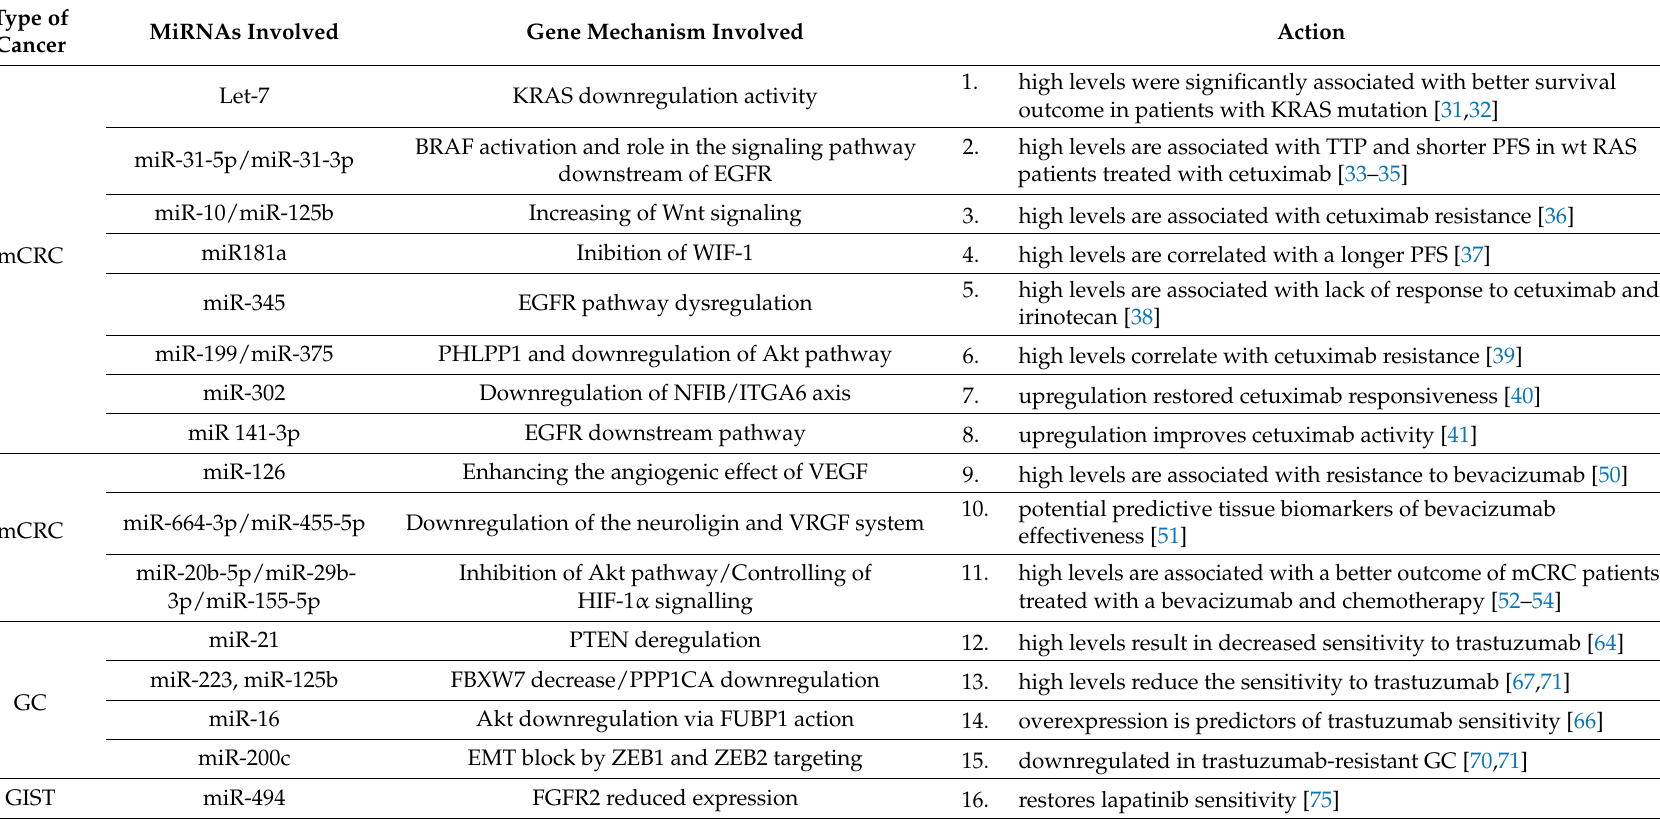
Table 1. miRNAs involved in resistance to targeted therapies in GI